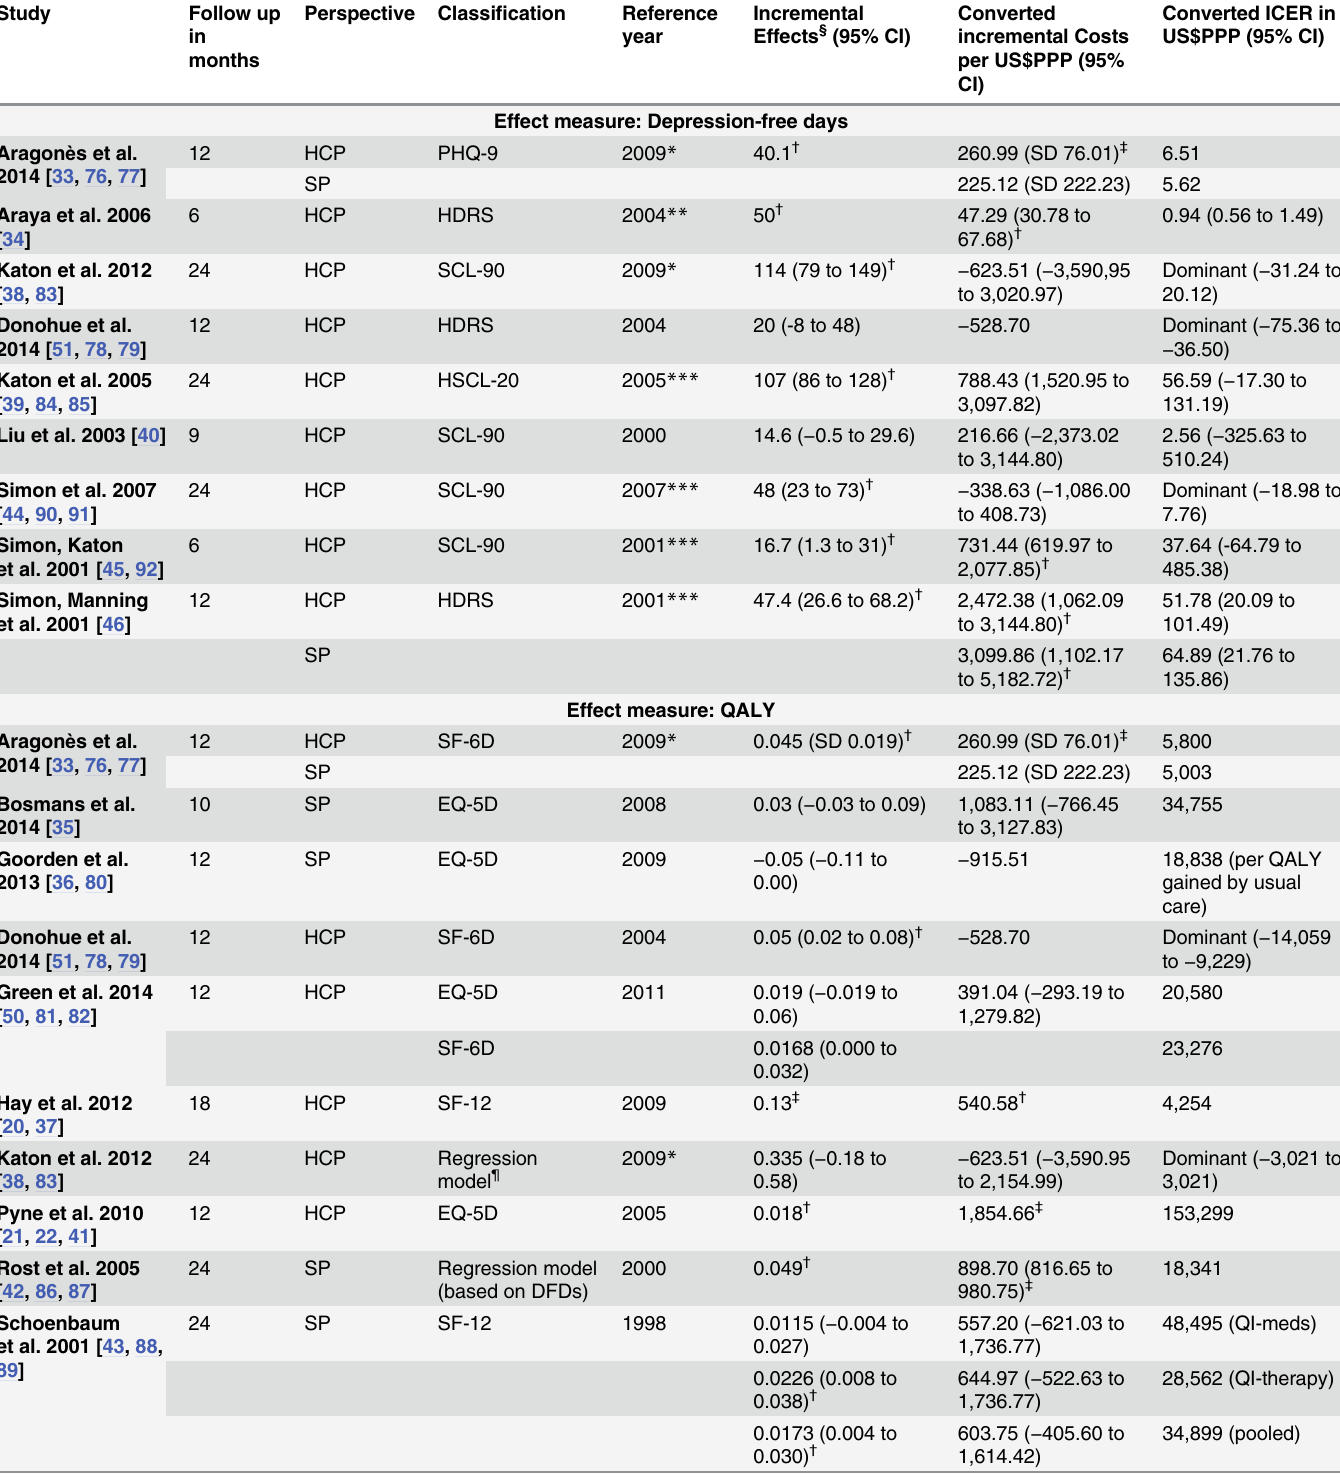
Table 2. Cost-effectiveness of collaborative care vs. usual